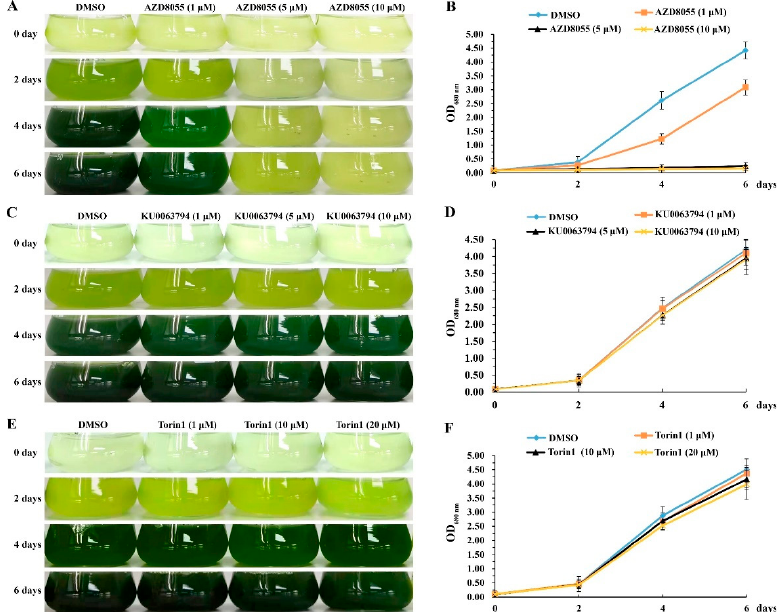
Figure 3. The effects of TOR protein inhibitors on the growth of Auxenochlorella pyrenoidosa. ( A ) AZD8055 inhibits the growth of A. pyrenoidosa in a dose-dependent manner. ( B ) Change curves of OD680nm values of A. pyrenoidosa treated with 1, 5 and 10 μ M AZD8055 for 0, 2, 4 and 6 days. ( C ) Phenotype of A. pyrenoidosa treated with 1, 5 and 10 μ M KU0063794 for 0, 2, 4, and 6 days. ( D ) Change curves of OD680nm values as described in ( C ). ( E ) Phenotype of A. pyrenoidosa treated with 1, 10, 20 μ M Torin1 for 0, 2, 4, and 6 days. ( F ) Change curves of OD680nm values as described in ( E ).